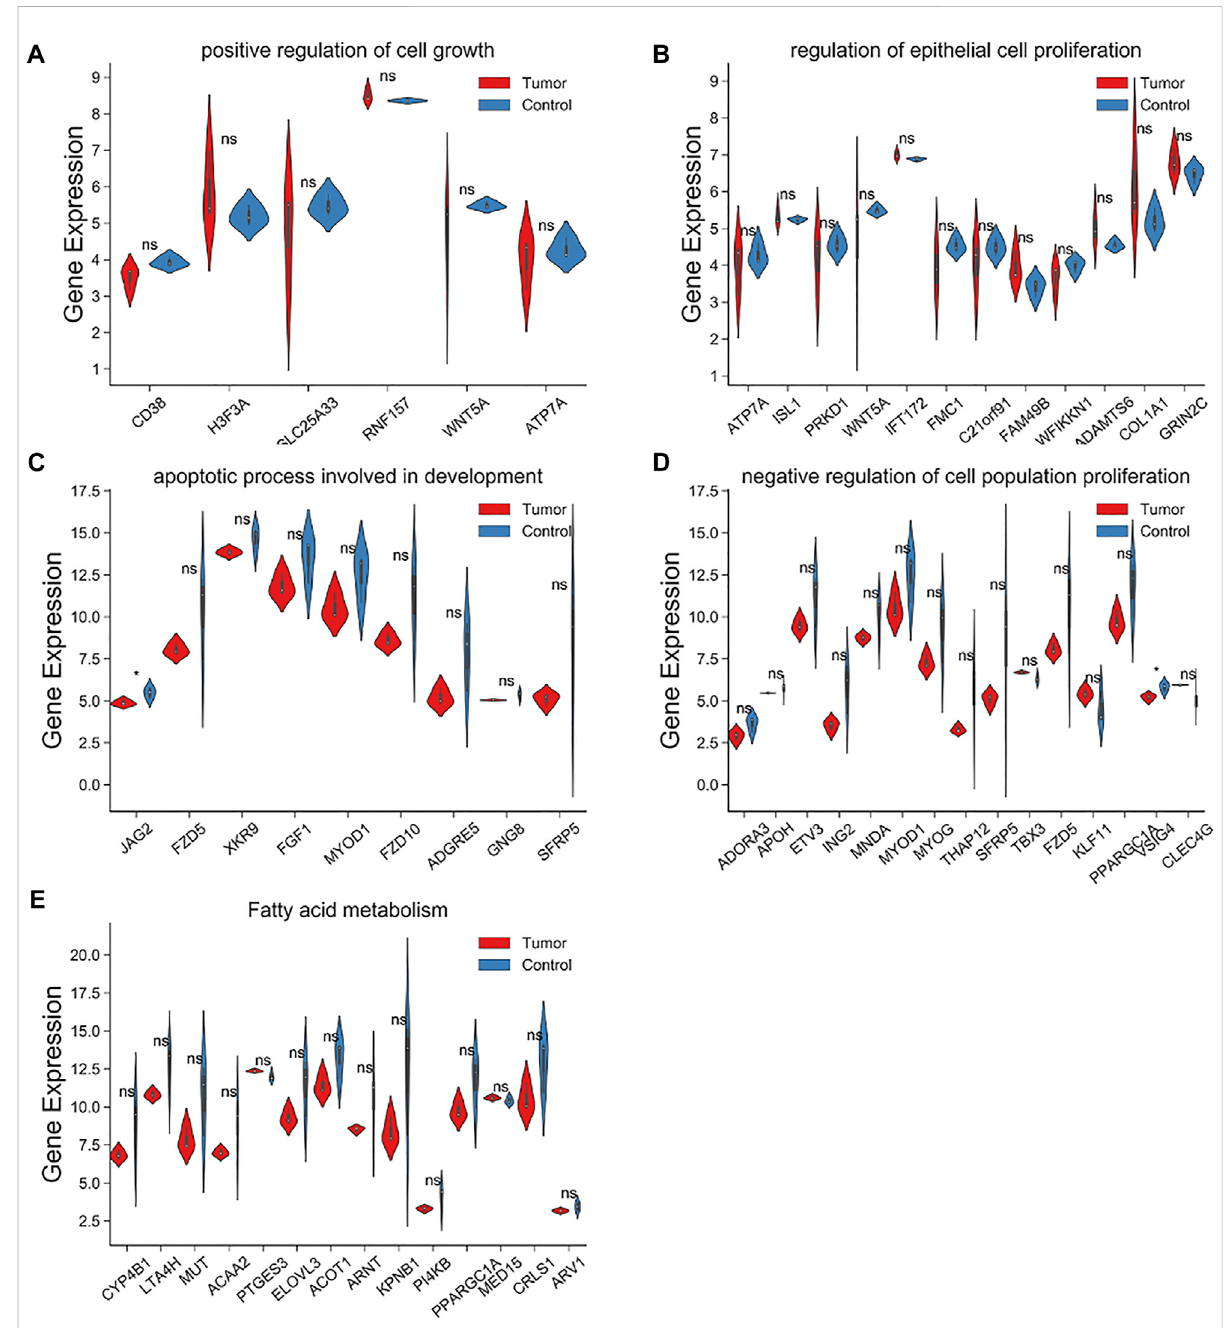
FIGURE 5 ExpressionofthetRF-1001andtRF-3004atargetgenesintheExo-LT(T)andtheExo-AT(C)groups. (A,B) Geneexpressionofthetargetgenesof tRF-1001 which positively regulated cell growth pathway and the epithelial cell proliferation pathway. (C – E) Gene expression of the target genes of tRF-3004a that were involved in the apoptotic process and in developmental pathway, and in the negative regulation of cell proliferation and fatty acid